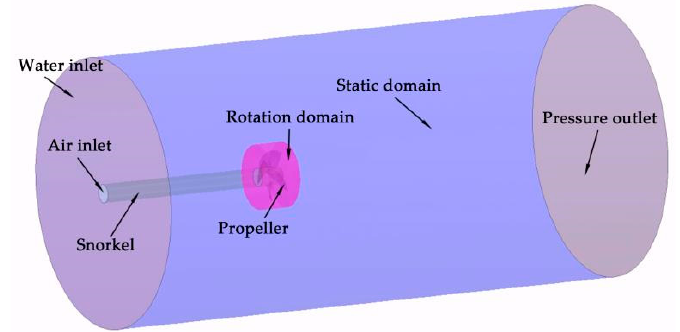
Figure 3. Oblique view of propeller and computational field.